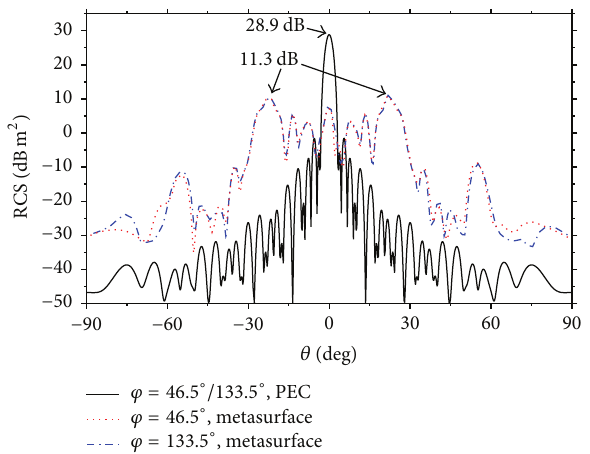
Figure16:ComparisonofthebistaticRCSat17GHzalong 𝜑 = 46.5 ∘ and 133.5 ∘ plane for the metasurface and the PEC